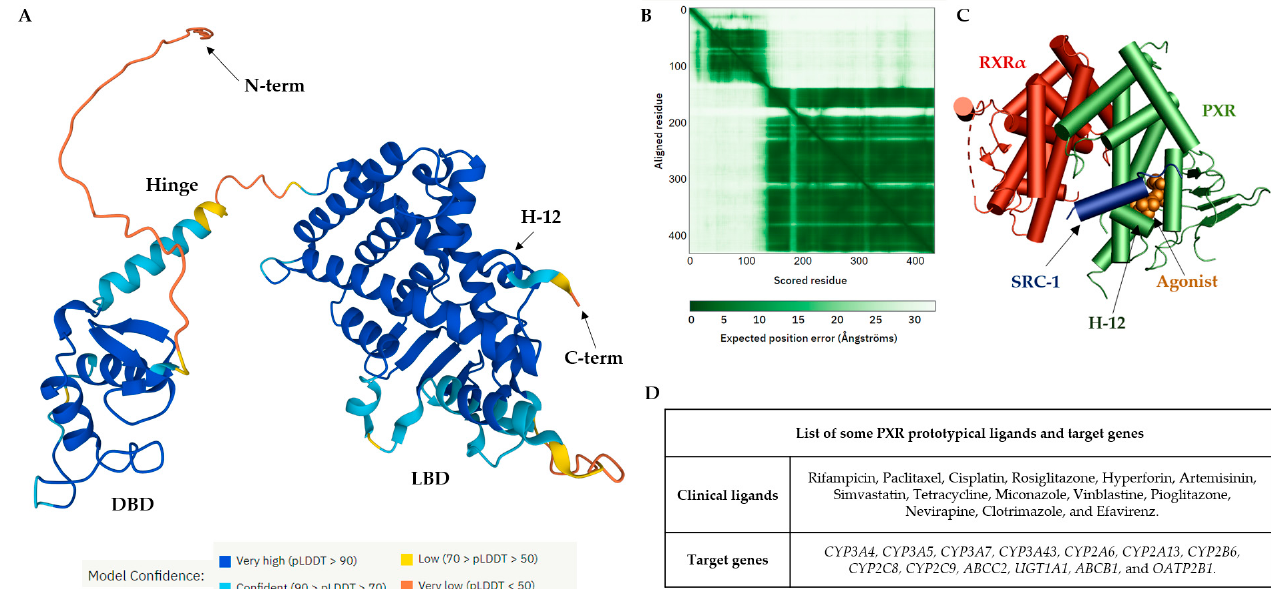
Figure 1. Structure of the PXR receptor. ( A ) AlphaFold2 prediction of the full-length chain of apo-PXR model (UniProt-O75469). A ribbon model of PXR coloring ranges from blue (high confidence of the predicted structure) to red (low confidence of the predicted structure). ( B ) Predicted aligned error plot (PAE) for the PXR. The shade of green indicates expected distance error in angstroms. Dark green represents low error, and light green represents high error indicated in the N -terminal/hinge regions of PXR. ( C ) Crystal structure of the PXR/RXR α LBD complex. The liganded PXR (green) and RXR α (red) bind to the steroid receptor coactivator peptide 1 (SRC-1/blue). The PXR agonist SR12813 is indicated in orange (PDB-4J5W) [7]. ( D ) List of some prototypical ligands and target genes for the nuclear receptor PXR.